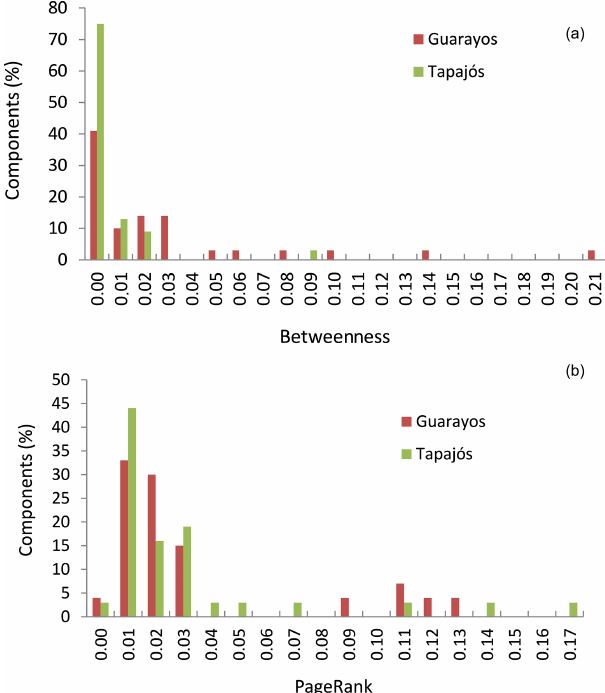
Figure 3. Frequencies of betweenness (a) and PageRank values (b) in both case studies: Guarayos (red) and Tapajós